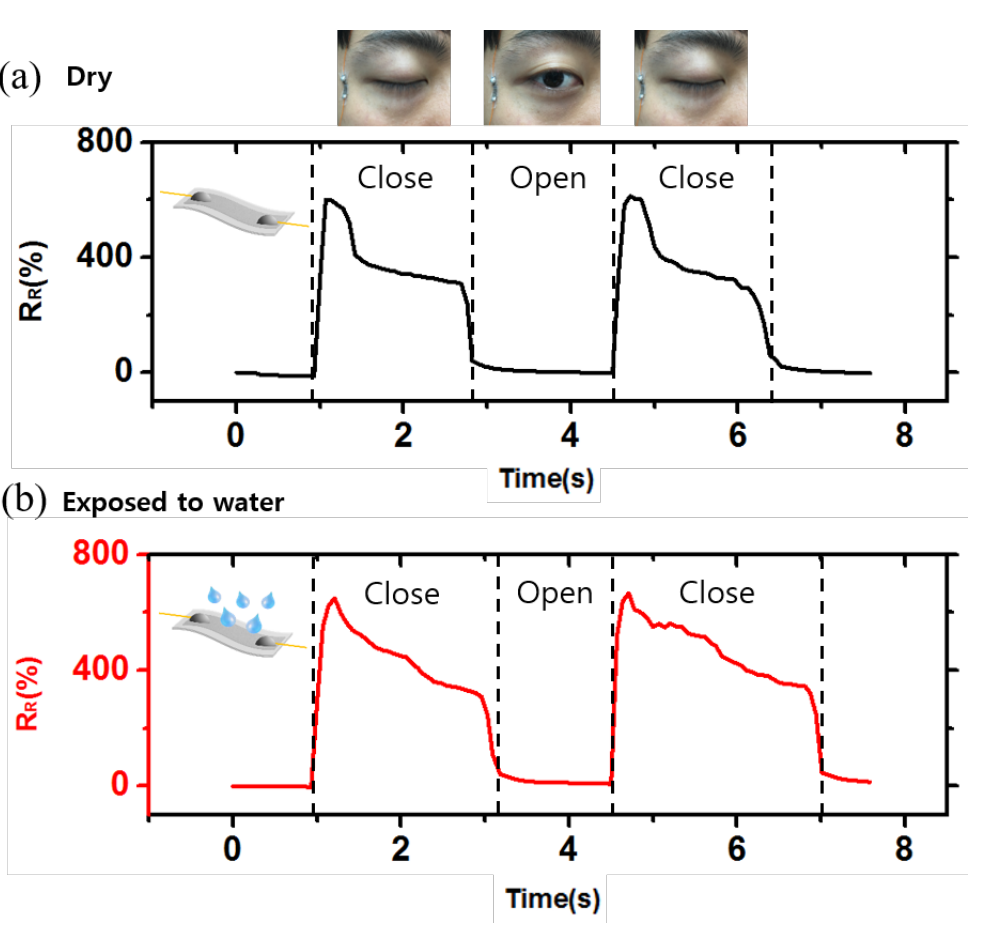
Figure 8. ( a , b ) Measurement of eyes blinking in dry conditions and when exposed to water.